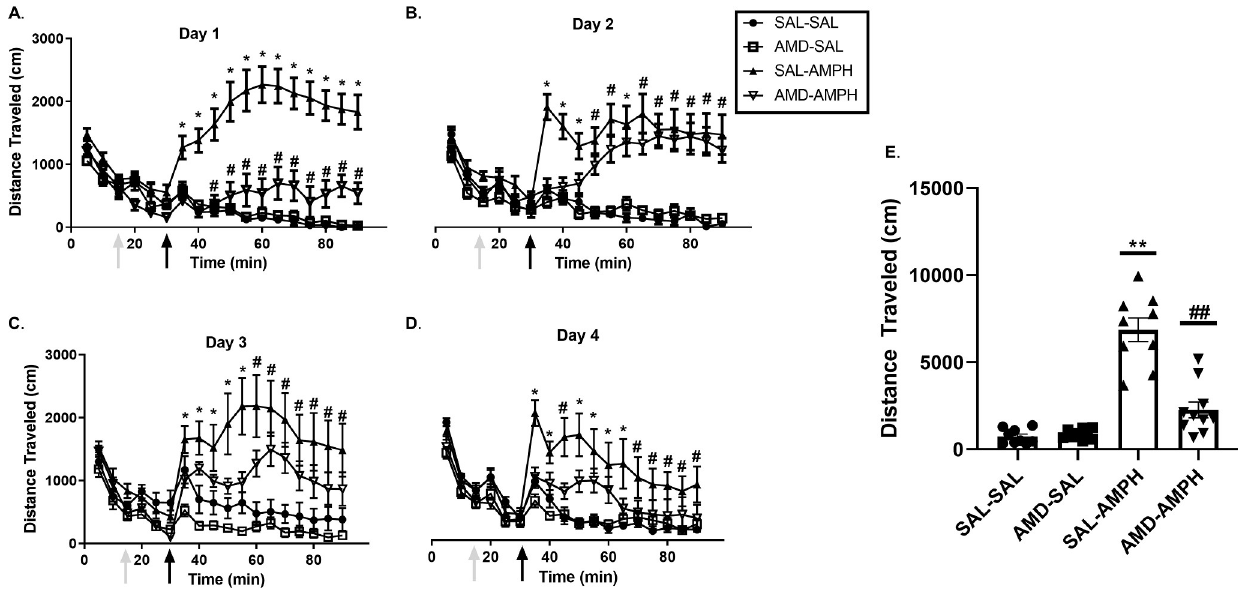
Fig 2. The locomotor effects of repeated pretreatment and treatment schedule on all experimental groups.